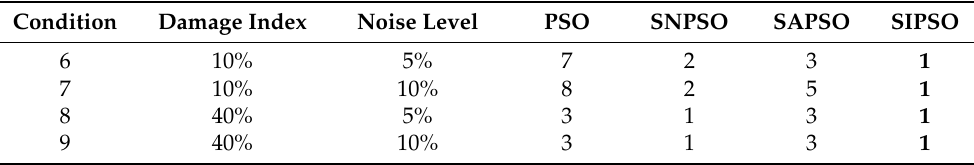
Table 6. Numbers of misjudgments in damage detection of four PSO-based algorithms with dou- ble